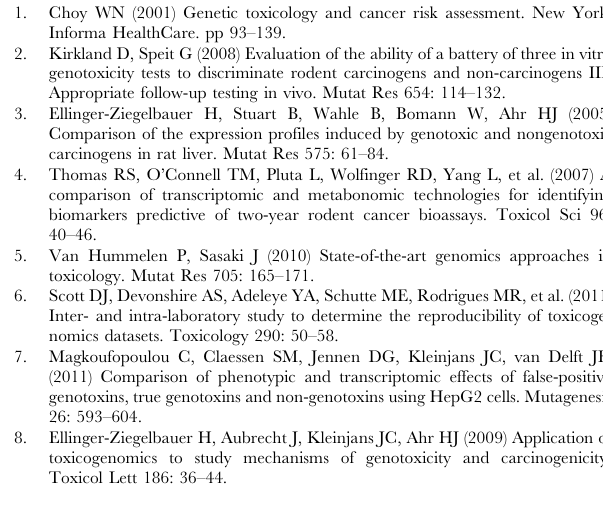
cells were treated with indicated concentrations of MMS. At and expression levels of BC were analyzed by quantitative PCR. Figure S4 Specific effects of BC siRNAs on cell growth and cell cycle progression. Expression level of BC ( A ), cell number ( B ) and cell cycle phase distribution ( C ) in NIH/3T3 cells transfected with indicated siRNAs at 48 h after transfection. Data were mean 6 s.d. of at least three independent experiments performed in triplicate. Values shown on top of bars are the P values vs corresponding scrambled siRNA. Figure S5 Representative western blot results showing protein level knock-down efficiency and specificity of siBC.2. NIH/3T3 cells were co-transfected with wild-type or mutant myc tagged BC clone with nonsense siRNA or siBC.2. Cell lysates were collected at 24 h after co-transfection. b -Actin served as a loading control. Primary antibody against Myc tag was from Cell Signaling (Danvers, MA, USA). Figure S6 Flow cytometric analysis of apoptosis in NIH/3T3 cells. NIH/3T3 cells were transfected with indicated siRNAs. At 48 or 96 h after transfection, apoptosis was